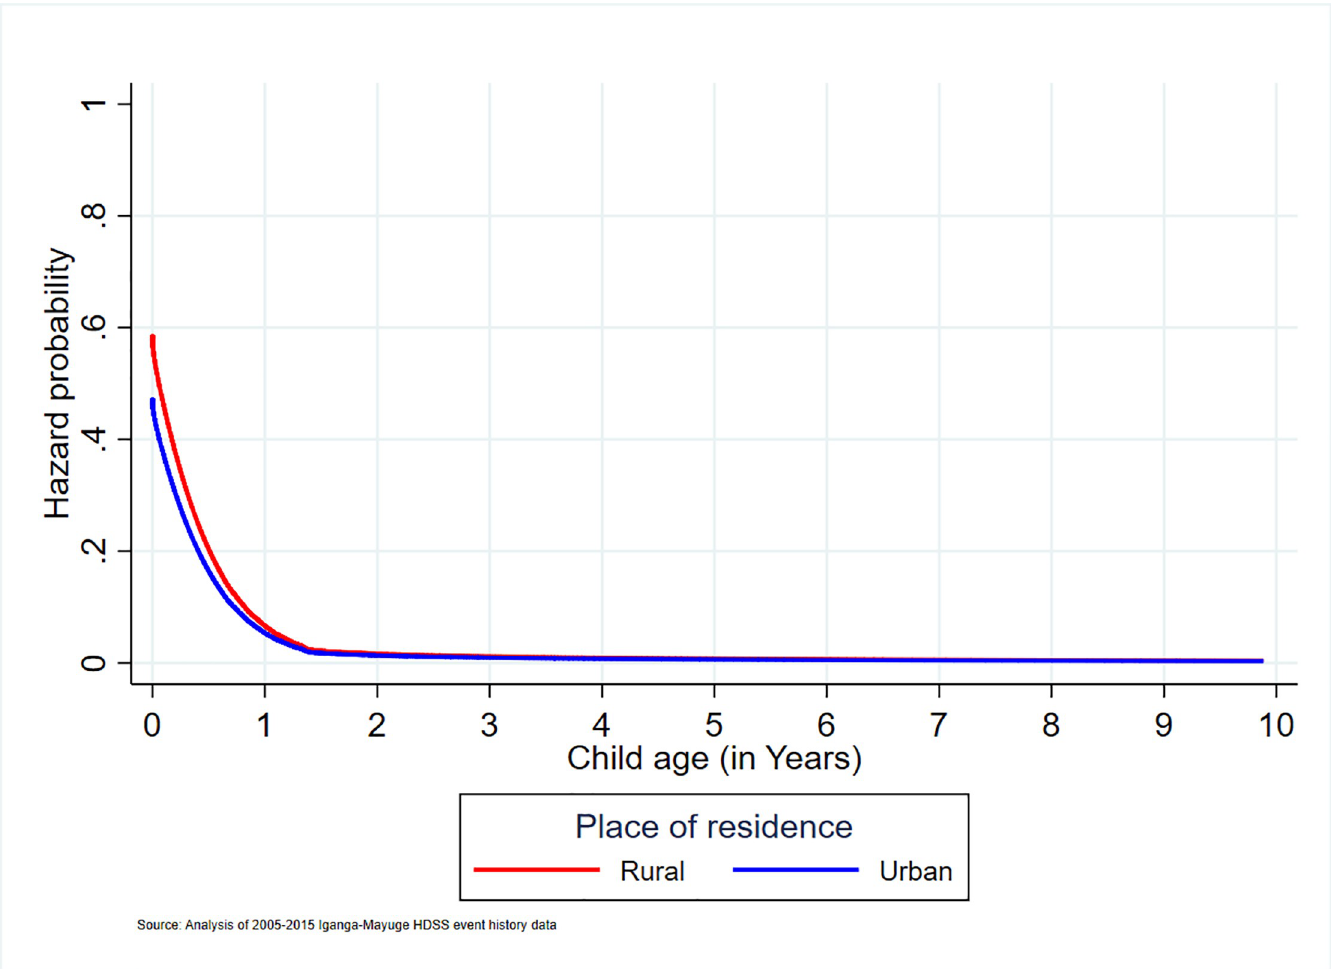
Fig 6. Association of place of residence with under-10